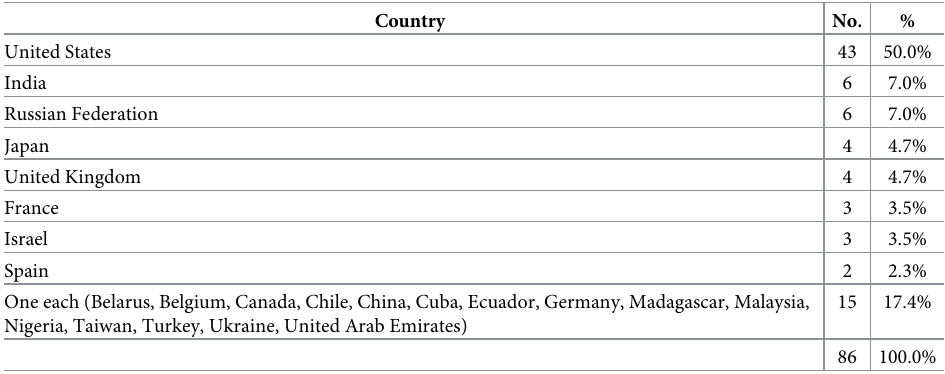
Table 3. Host country of organization for 86 websites in